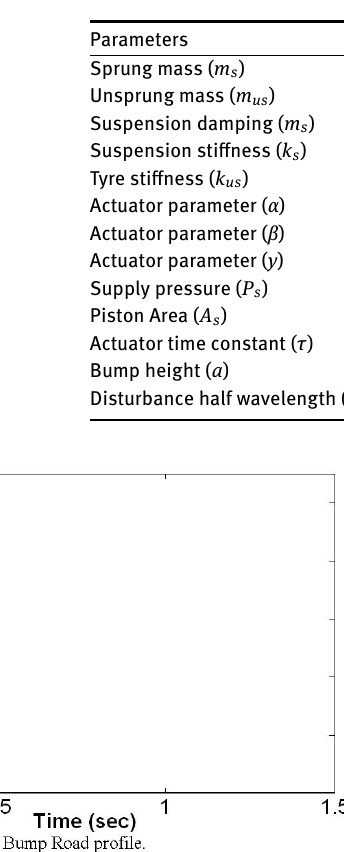
Table 1. Parameters of the quarter-car model.